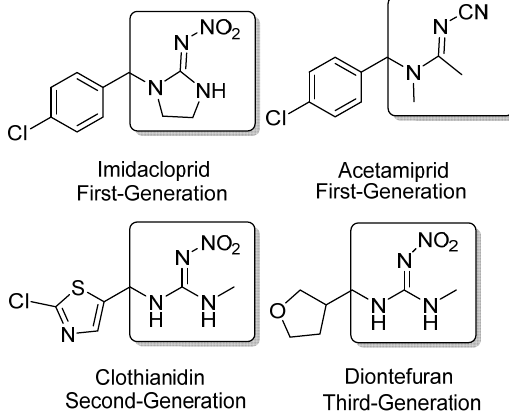
Figure 1. Representative generation of commercial neonicotinoid insecticides. Molecules 2018 , 23 , x FOR PEER REVIEW